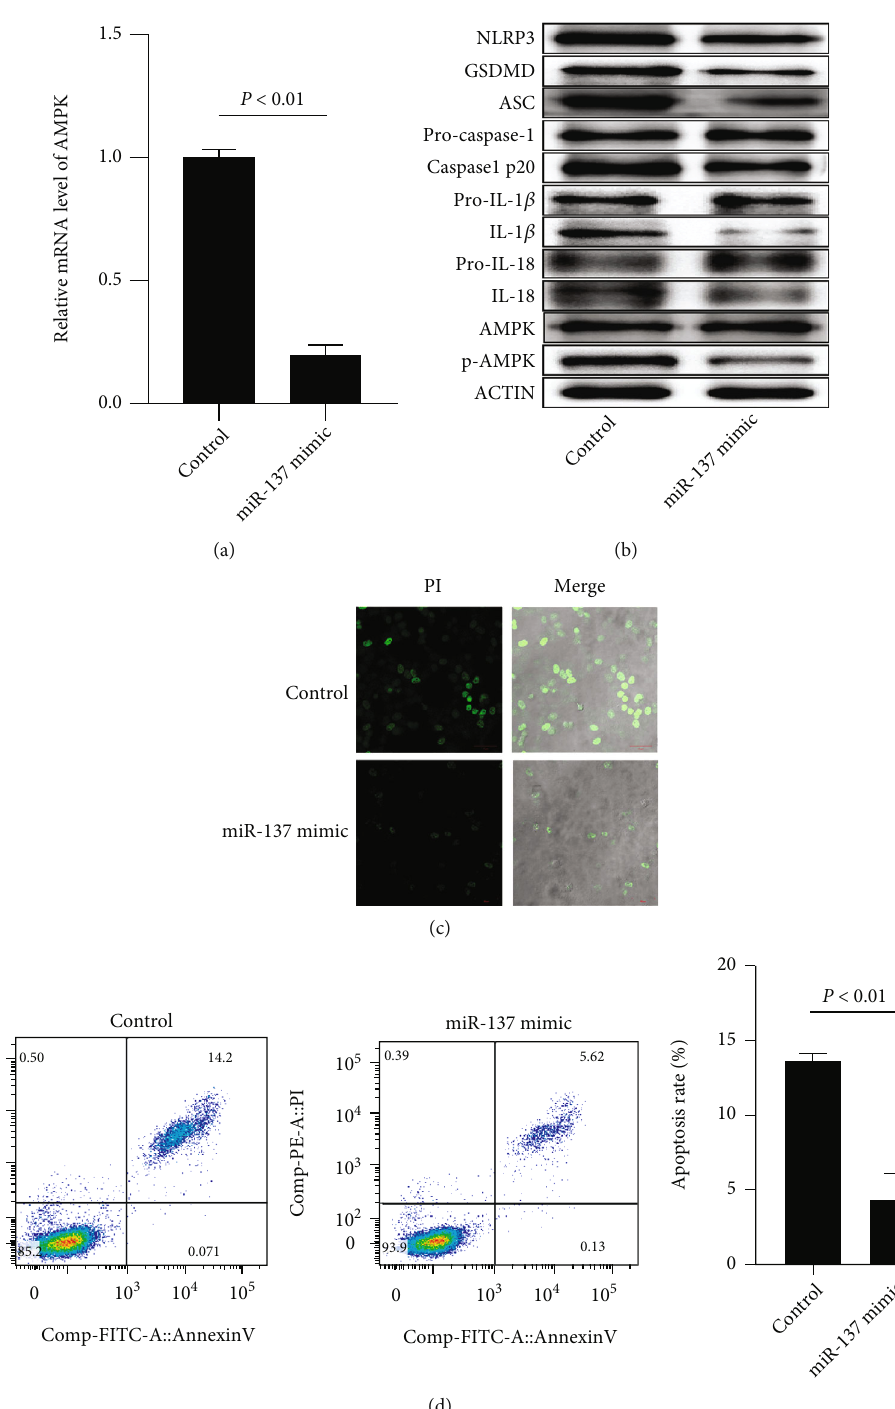
Figure 5: miR-137 mimic inhibits CD4+ T cell pyroptosis via mediating AMPK in SLE. (a) AMPK mRNA expression in SLE patients ’ CD4+ T cells after transfecting miR-137 mimic. (b) In fl ammation and pyroptosis-related proteins in SLE patients ’ CD4+ T cells after transfecting miR-137 mimic. (c) In fl uence of miR-137 mimic transfection on SLE patients ’ CD4+ T cell pyroptosis. (d) Impact of miR-137 mimic transfection on SLE patients ’ CD4+ T cell apoptosis. Each test ran in triplicates. The means were pairwisely compared using Student ’ s t -test. P < 0 : 01 means the presence of statistical signi fi